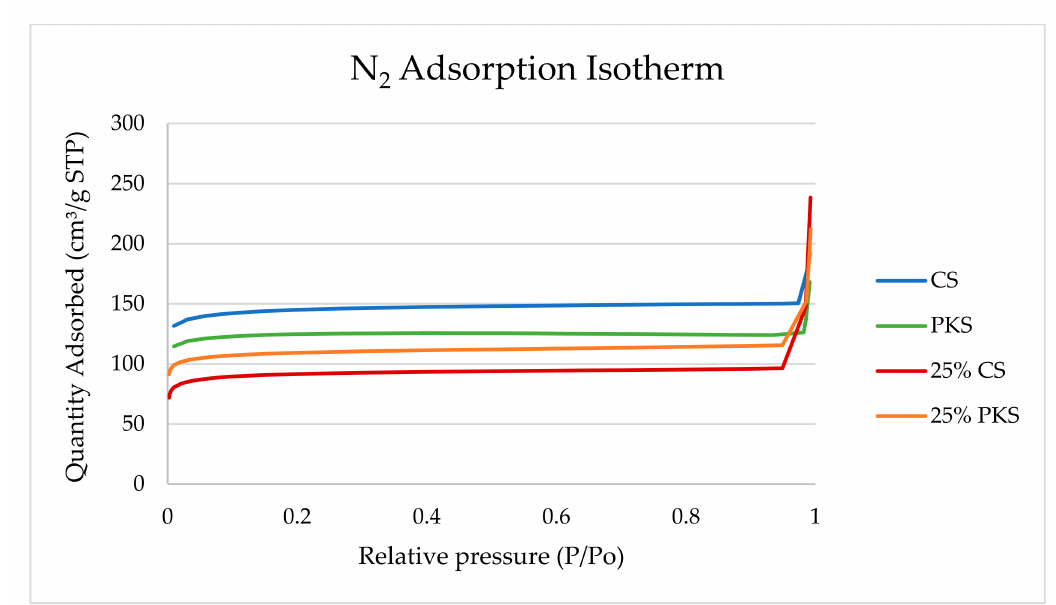
Figure 3. N 2 adsorption isotherm for activated carbon prepared at 700 ◦ C for 75 min (reference sample) and activated carbon (700 ◦ C, 75 min) post-treated with 25%